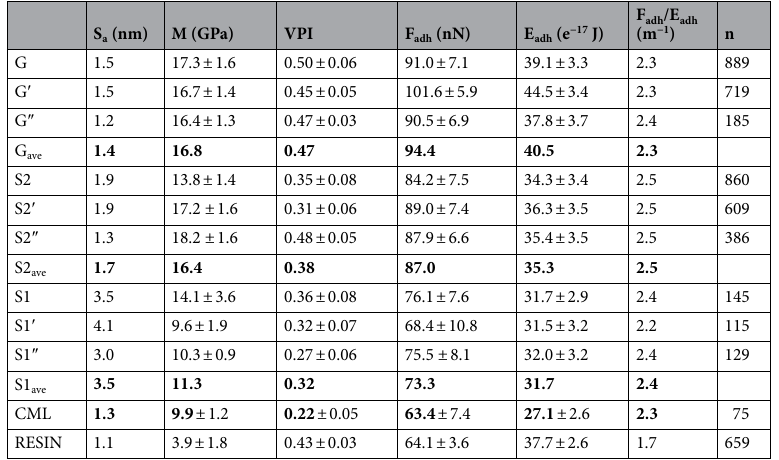
Table 1. Physical parameters extracted from Figs. 6 e–h mappings for the different wood cell wall layers of three nearby wood cells. n is the number of indentation measurements performed for each analyzed